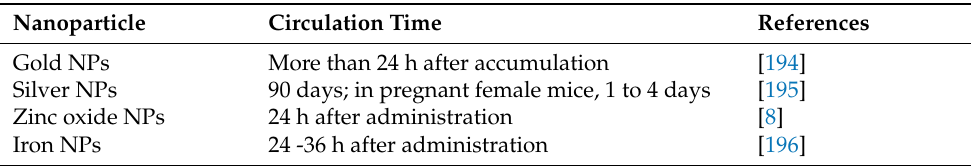
Table 15. Circulation time of nanoparticles in cancer therapy.